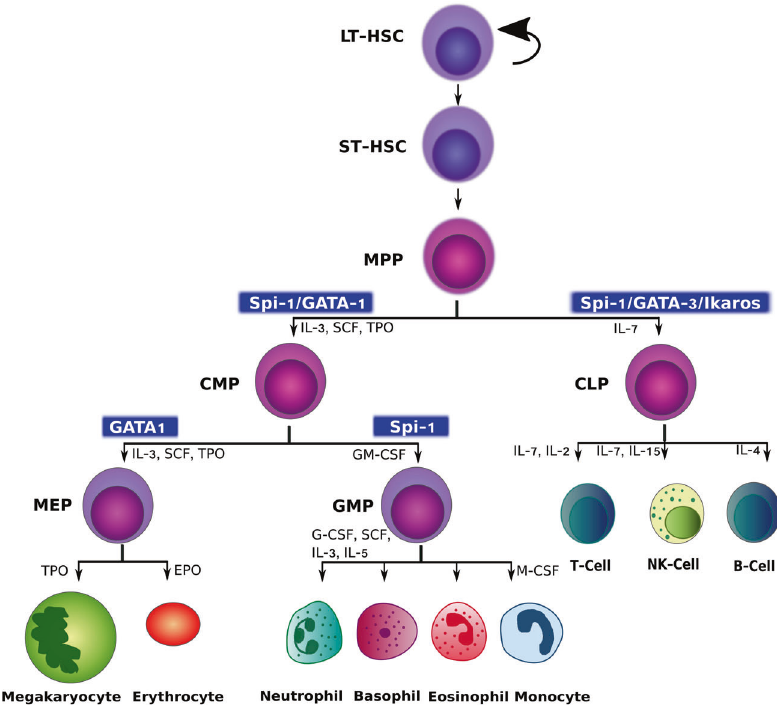
Fig. 2 Implications of GATA-1 and Spi-1 in myeloid differentiation of hematopoietic pathway. Hematopoietic stem cells (HSC) evolve from long-term (LT), short term (ST) to multipotent progenitor cells (MPP) from which myeloid and lymphoid cells are formed. At this stage, multiple cytokines along with transcription factors — Spi-1 and GATA1 provide necessary cues for the development of common myeloid progenitor (CMP). However, the next line of myeloid differentiation to megakaryocyte-erythrocyte progenitor (MEP) and granulocyte- monocyte progenitor (GMP) is carried by distinct signaling of GATA1 and Spi-1, respectively. This is followed by the formation of all types of blood cells namely, megakaryocytes (platelets), erythrocytes (RBCs), neutrophils, basophils, eosinophils, and